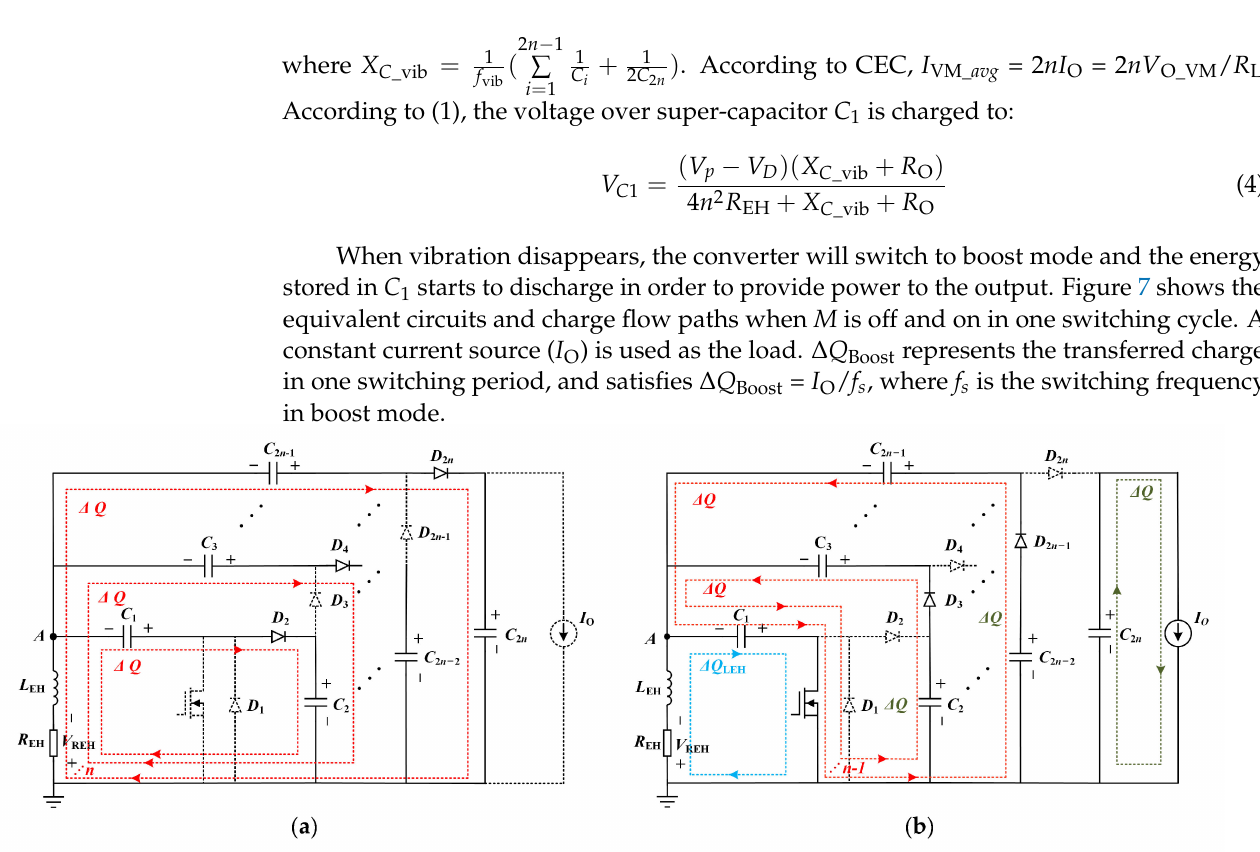
Figure 7. ( a ) The charge flow when M is off in boost mode; ( b ) the charge flow when M is on in boost